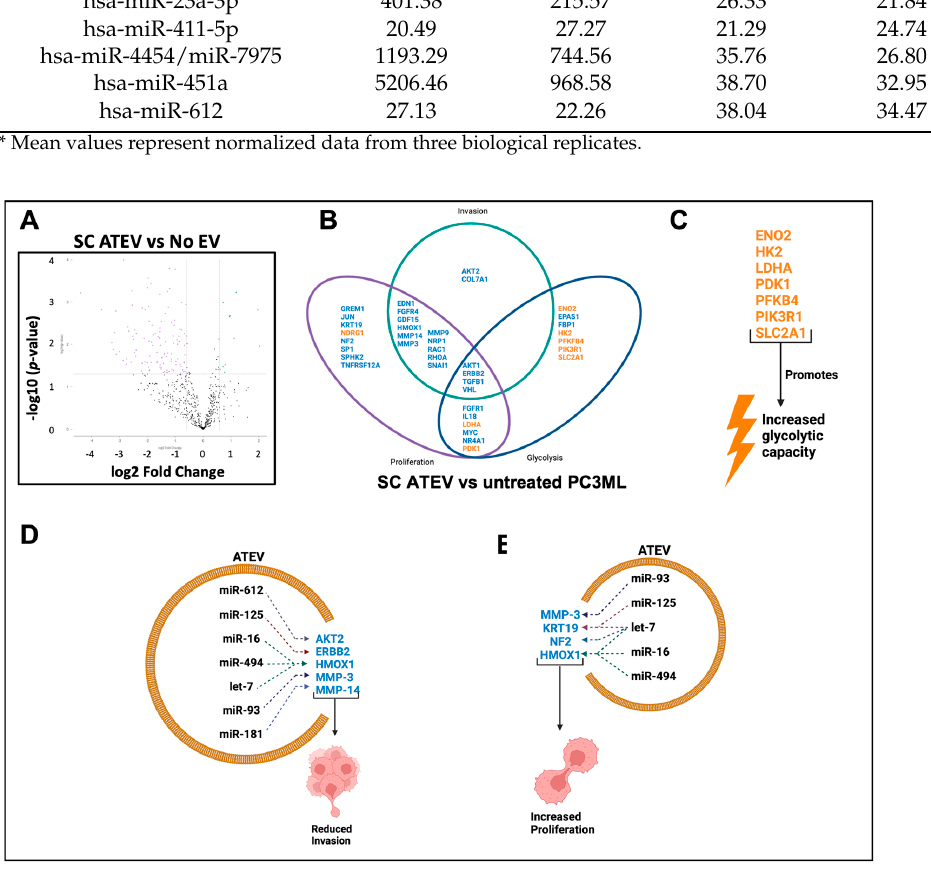
Figure 7. ATEV alters the molecular signature of PC3ML . Volcano plots show DE genes with an x-axis indicating DE fold change with a threshold +/ − 0.58 log2 fold change, p < 0.05. SC ATEV changed expression of 108 genes ( A ). Of the 108 deregulated genes, 29 were associated with proliferation, 17 with invasion, and 17 with glycolysis ( B ). ATEV upregulated multiple genes that may impact on observed increase in glycolytic activity ( C ). miRNA contained within ATEV was found to target deregulated genes that may impact on observed reduction in invasion ( D ) and increased prolifera- tion ( E ). Genes in blue are downregulated, and genes in orange are upregulated. Table 9. miRNA detected in SC and OM ATEV . Table 11. Genes deregulated in ATEV-treated vs. untreated PC3MLs.